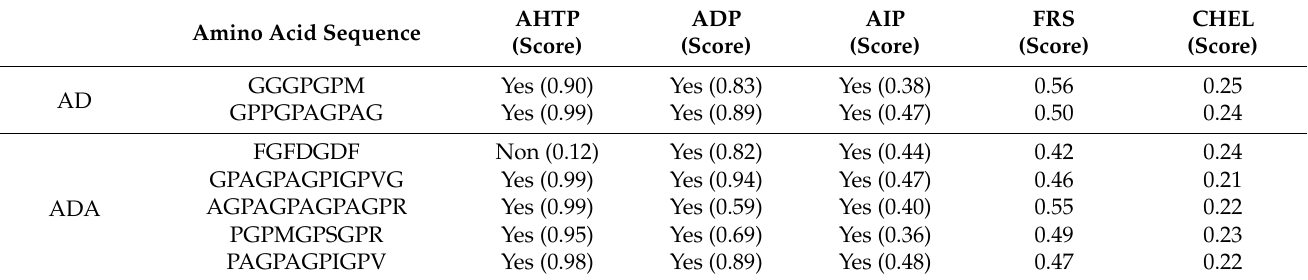
Table 2. The predicted bioactivity of nontoxic and non-allergenic peptides.